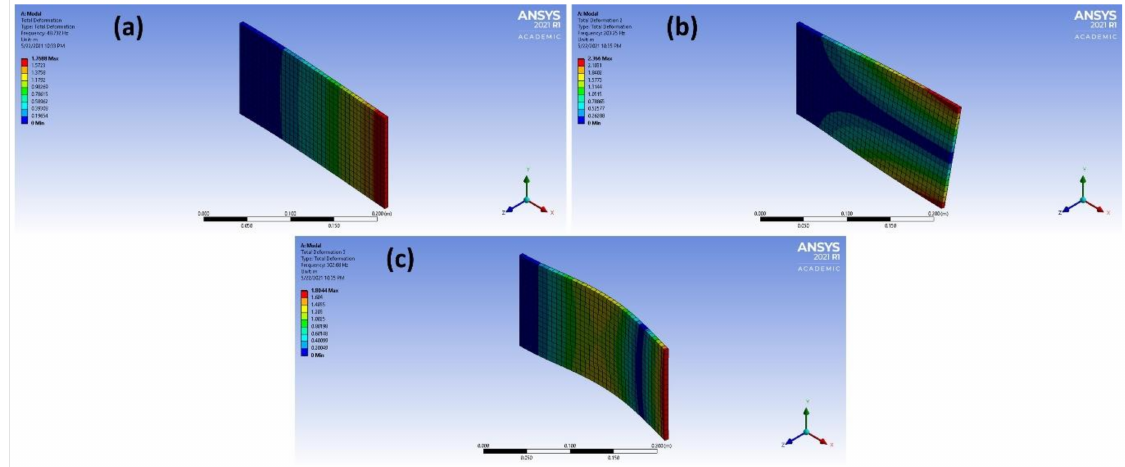
Figure 2. ( a – c ) Overview of different mode shapes obtained of the copper plate after the processing of data.